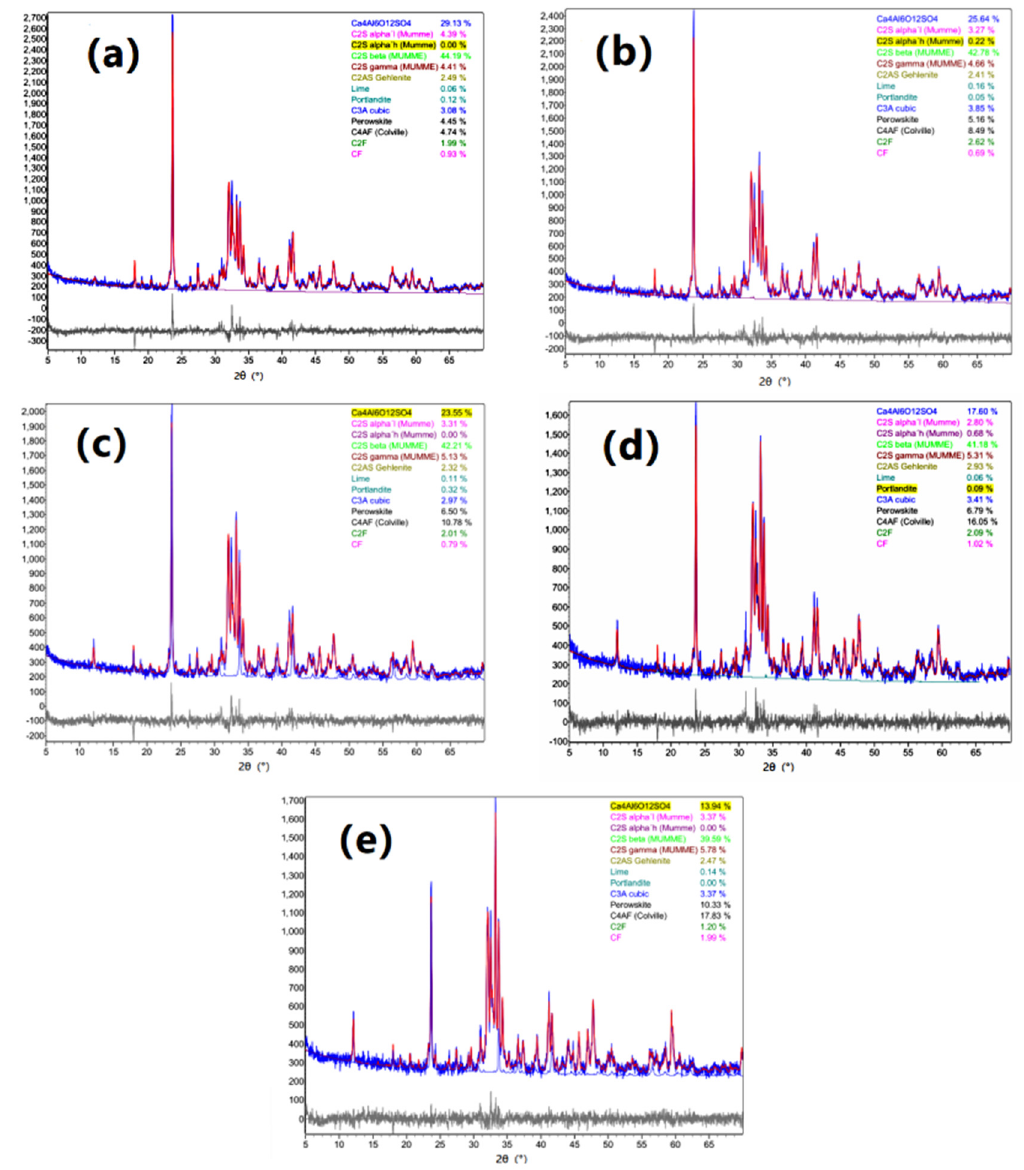
Figure 4. QXRD patterns of HBSC clinker containing brownmillerite ( a ) GF-1, Rwp = 5.80%, ( b ) GF-2,